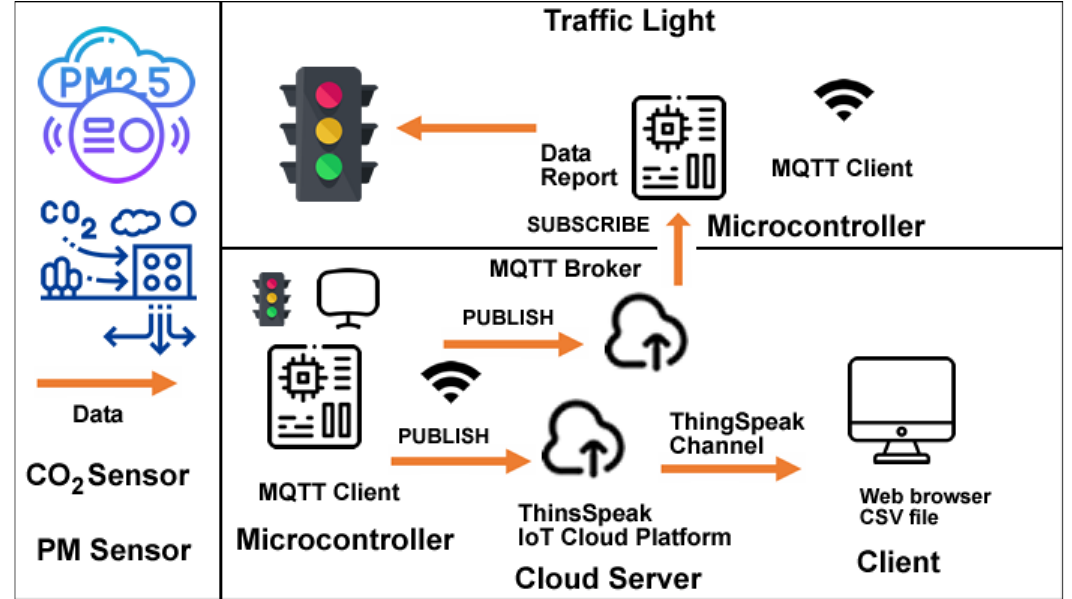
Figure 10. SmartAir System Architecture.